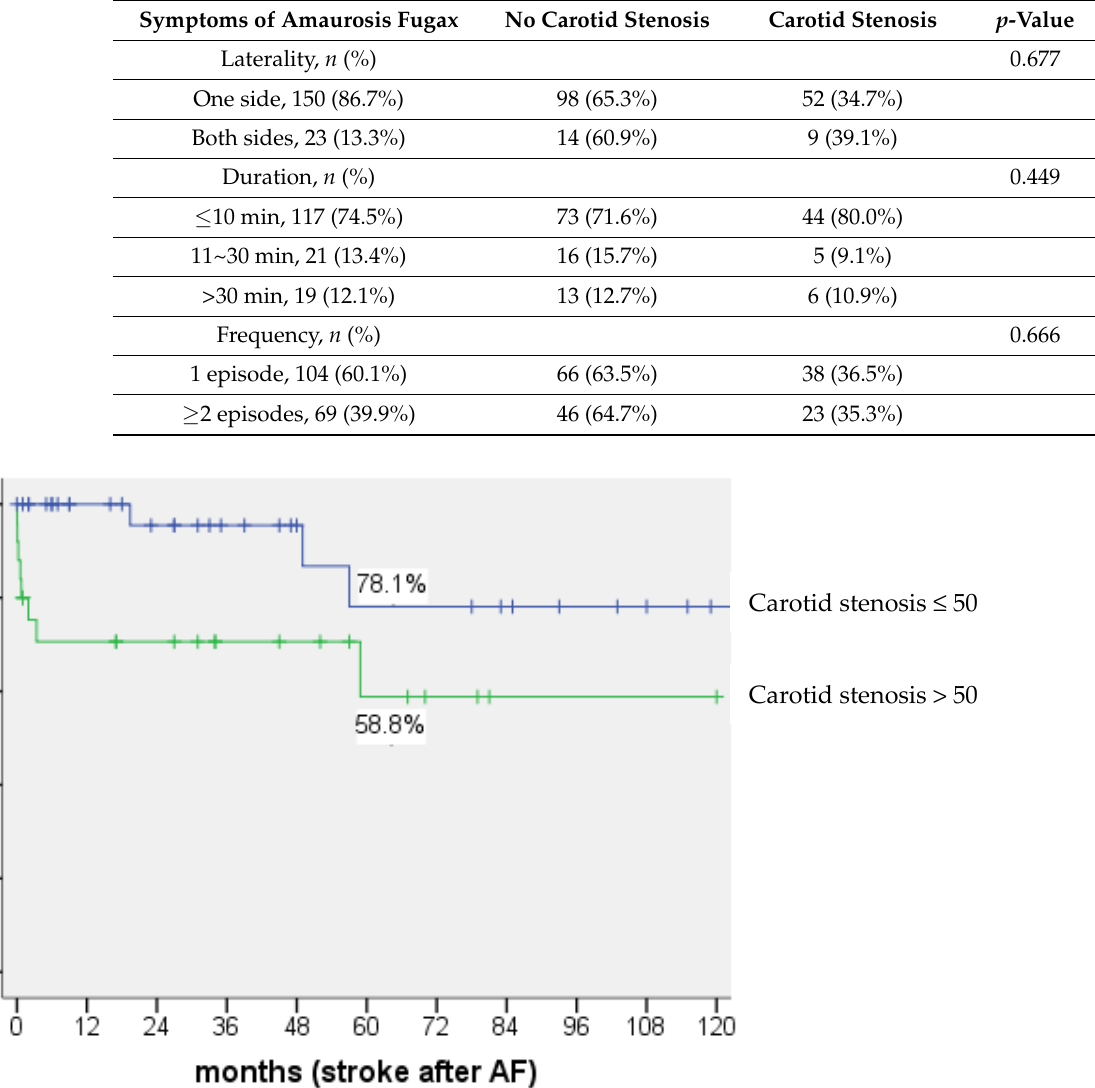
Table 2. Association between symptoms of amaurosis fugax and carotid stenosis.